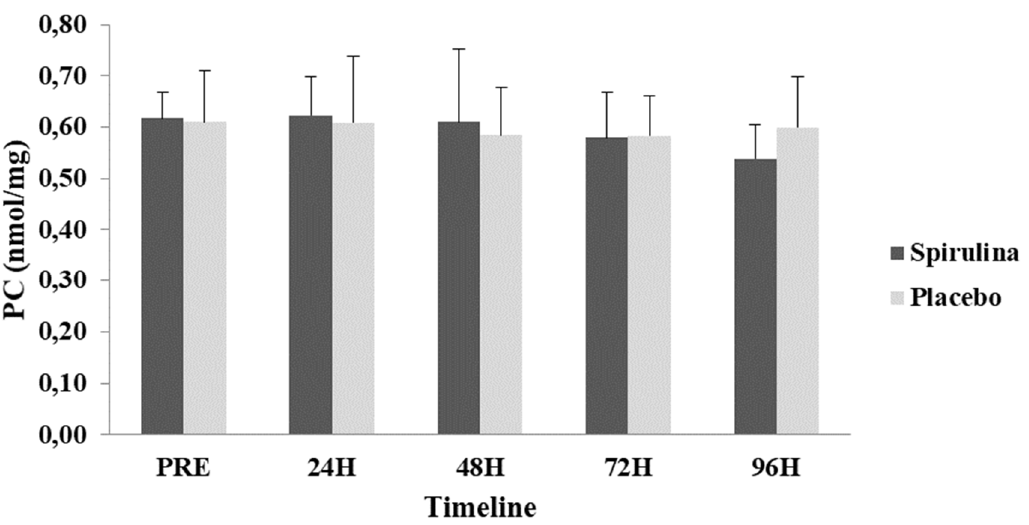
Figure 6. Change in protein carbonyls (PC) concentration in response to eccentric protocol. PRE, Baseline measurement; H, Hours.